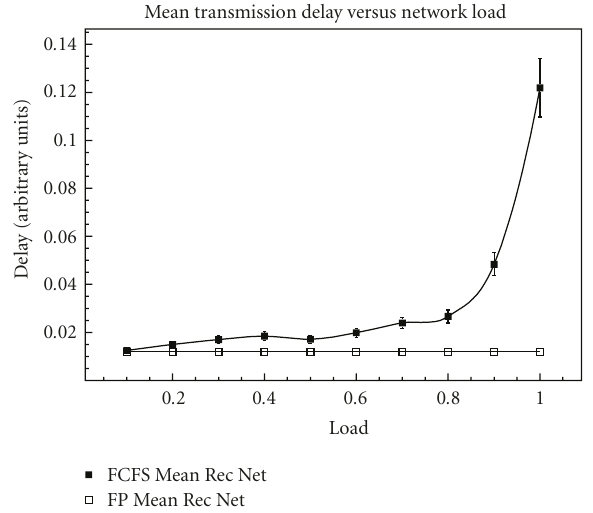
Figure 11: Time delay to read data packets induced by concurrent activities using a FCFS scheduling policy.